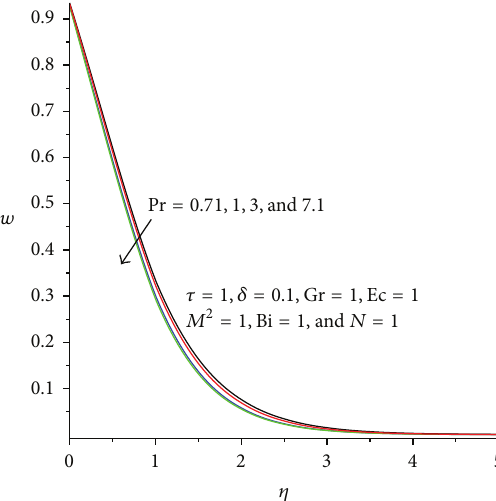
Figure 8: Velocity profiles with increasing 𝛿 .